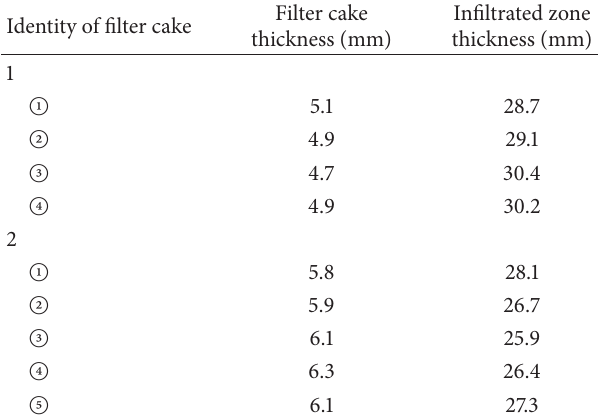
Table 2: Morphology of the filter cakes in the test. Identity of filter cake